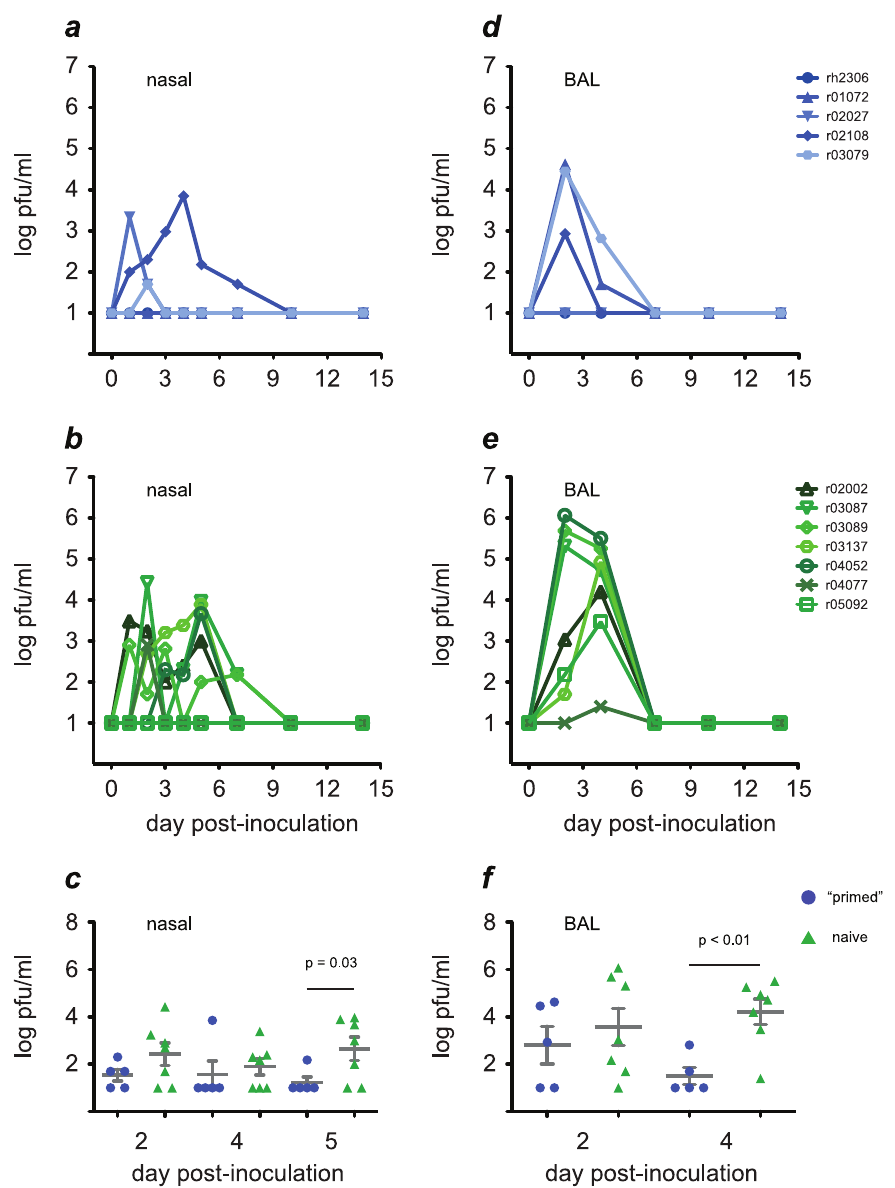
Figure 7. ‘‘Primed’’ animals clear H1N1pdm infection more rapidly than naive animals. We used plaque assays to monitor replication of H1N1pdm in the upper respiratory tract (nasal secretions) and lower respiratory tract (BAL) in ‘‘primed’’ (blue traces, solid symbols) and naive animals (green traces, open symbols). a and b , kinetics of H1N1pdm replication in nasal secretions. c , By day 5 post-inoculation virus titers in nasal secretions were significantly lower in ‘‘primed’’ than naive animals. d and e , H1N1pdm replication kinetics in the lung. f , By day 4 post-infection virus titers in lung were significantly lower in ‘‘primed’’ than naive animals.